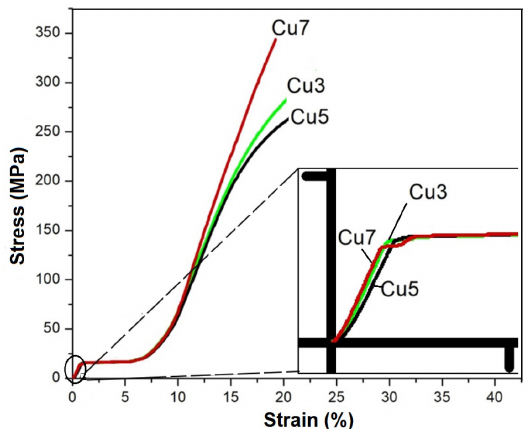
Figure 9. Compressive stress-strain curves for the experimental alloys